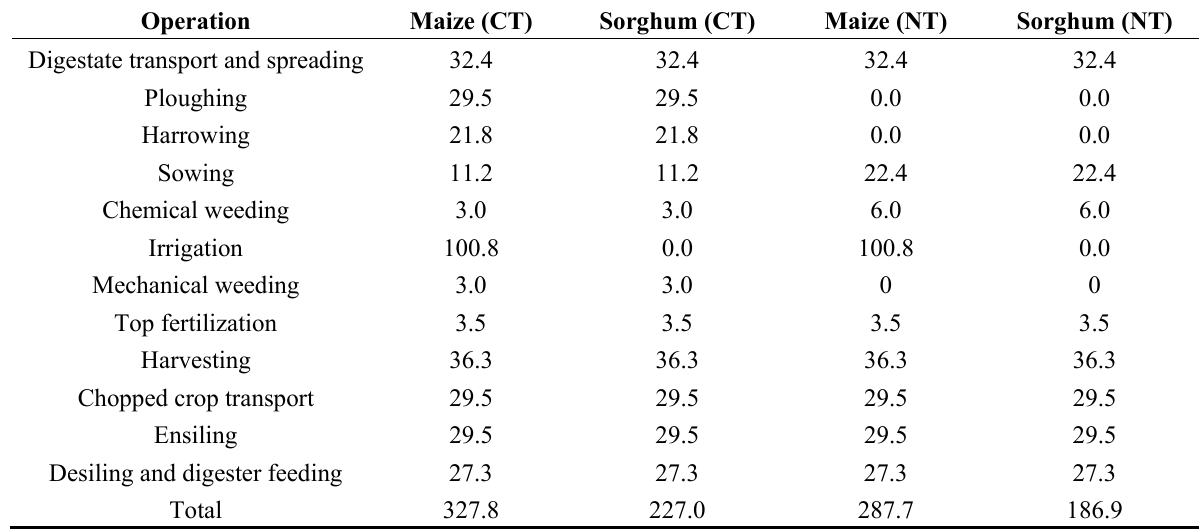
Table A2. Diesel consumption (kg·ha − 1 ) by tractor and agricultural machinery per each operation during the cultivation and production of silage from maize and sorghum under conventional tillage (CT) and no tillage (NT) (elaborated from Bacenetti et al.